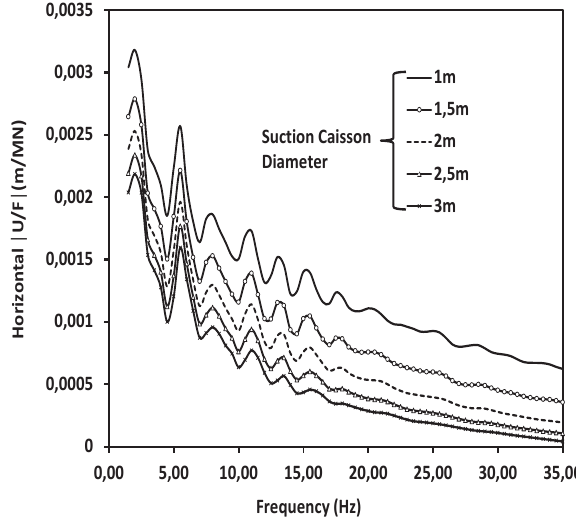
Figure 7 Vertical displacement amplitude │U/F│̶